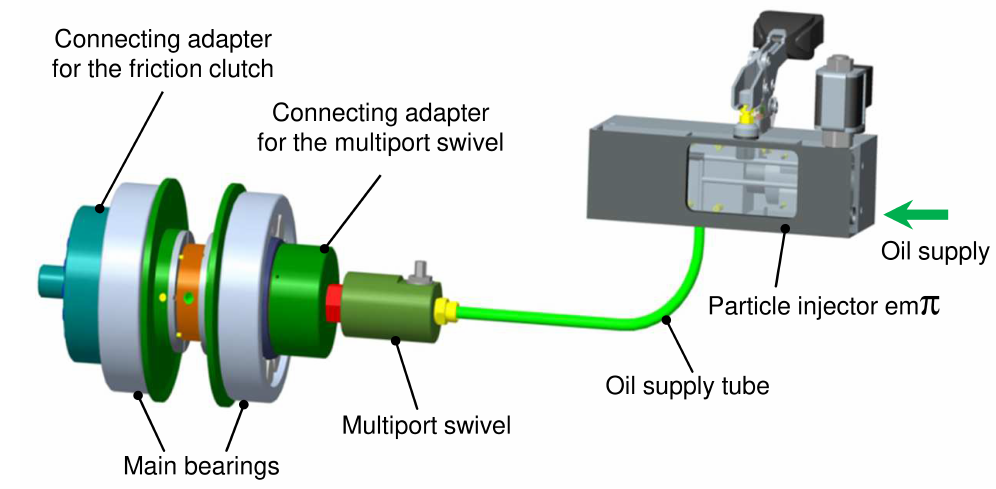
Figure 12. Particle injector for slide bearings.